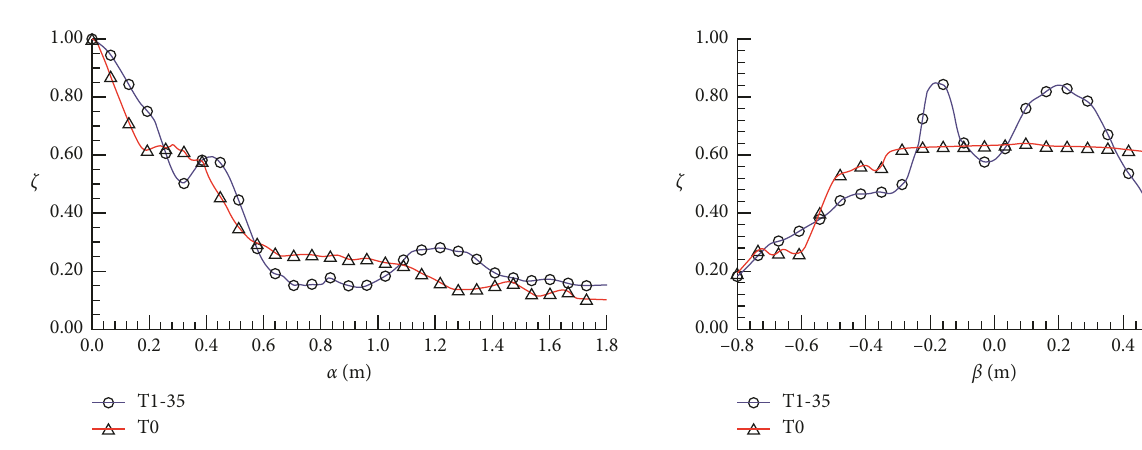
2 of the single pile test.